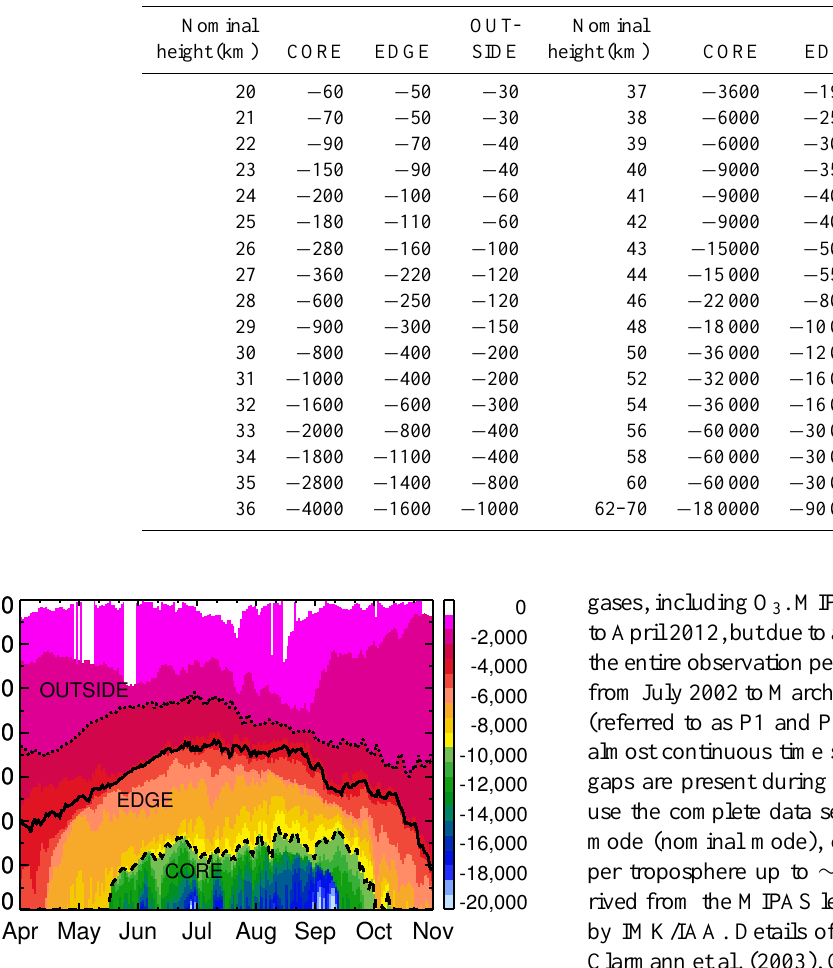
Figure 1. Potential vorticity (10 − 6 Km 2 s − 1 kg − 1 , colour scale) at ∼ 40km during the Antarctic winter 2011 as a function of time and equivalent latitude. The thresholds of the regions OUTSIDE (dot- ted line), EDGE (solid line) and CORE (dashed line) are included. Potential vorticity was calculated from ECMWF Era-Interim